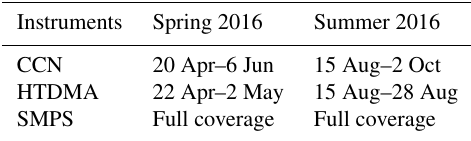
Table 1. Measurement periods during spring and summer field stud-